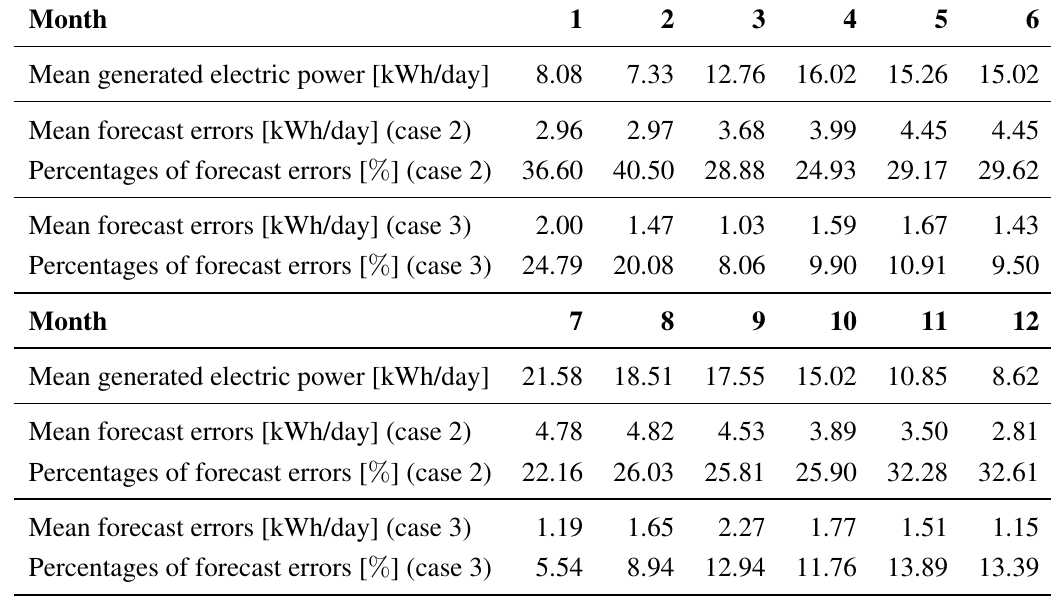
Table 4. Mean generated electric power of PV and forecast errors at Naha in